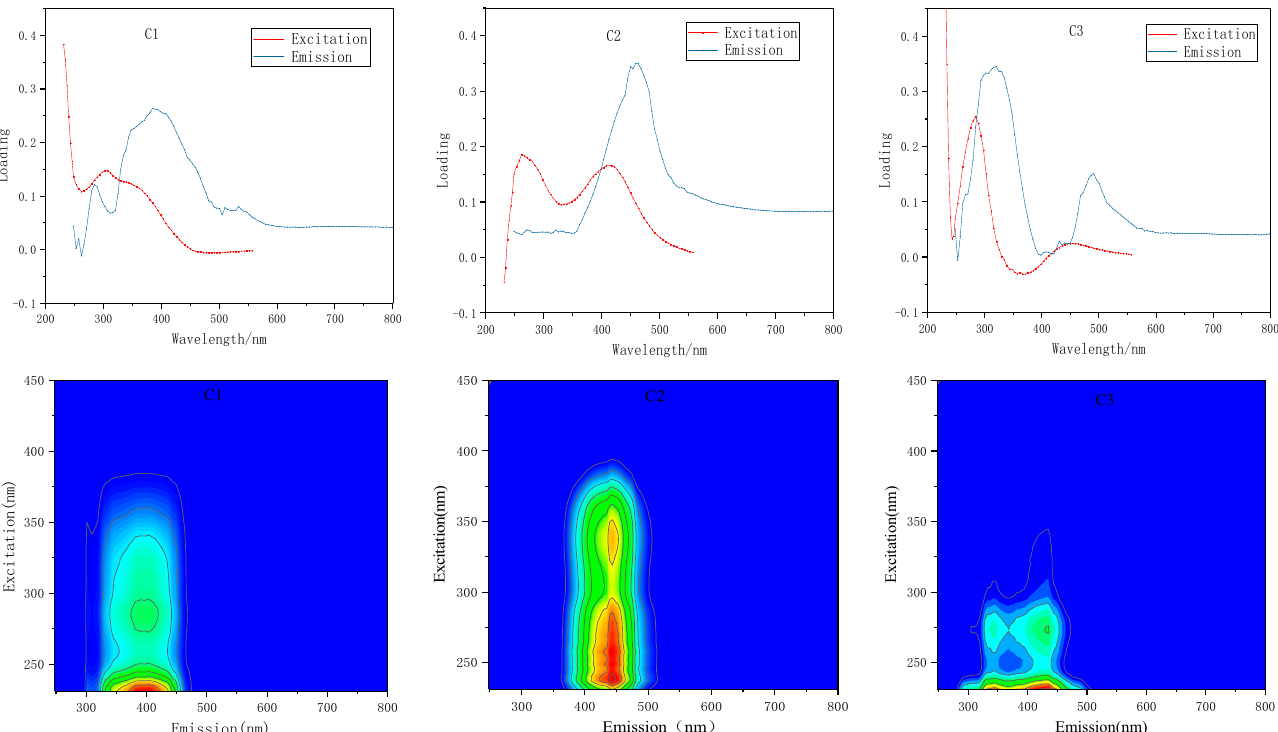
Figure 5. Three components identified by the PARAFAC model and Ex/Em loadings. (C1: humic-like components with carboxylic-like groups as primary compounds; C2: fulvic-like components with carboxylic-like and phenolic-like groups as primary compounds; C3: amino acids-like substances, easy to biodegradation and has strong correlation with human activities).